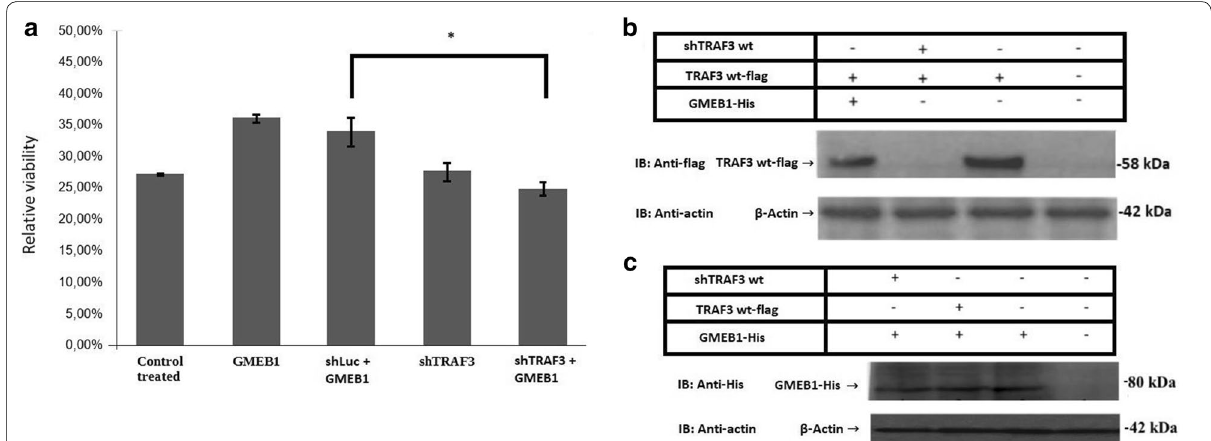
Fig. 4 Traf3 gene silencing abolishes the antiapoptotic function of GMEB1. a Assessment of viability of HeLa cells, treated by CHX and TNF-α, using MTT assay. A shRNA-expression vector targeting TRAF3 (shRNATRAF3) (0.5 μg), a control shRNA-expressing vector (shRNA luc) (0.5 μg) and GMEB1-His (1 μg) were cotransfected to HeLa cells. 20 h postransfection, HeLa cells were treated with CHX and TNF-α for 24 h, in order to